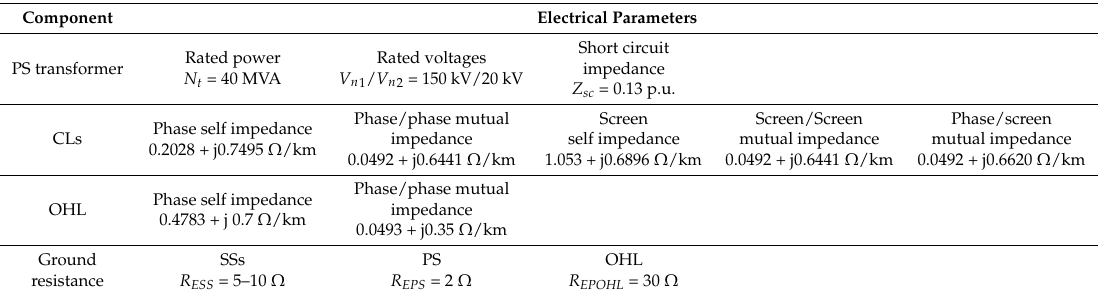
Table 1. Electrical parameters of the main components of the studied 150/20 kV–50 Hz system.